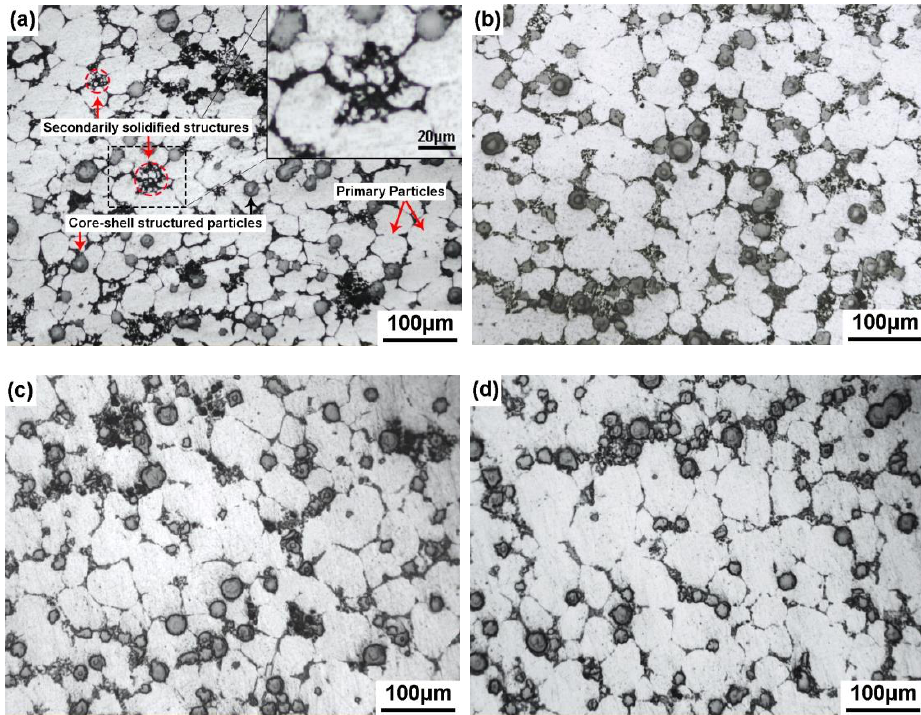
Figure 2. Optical microscope (OM) images of the composites thixoformed under mold temperatures of ( a ) 150 °C, ( b ) 200 °C, ( c ) 300 °C, and ( d ) 400 °C. Insert in ( a ) showing the secondarily solidified structures among the primary particles.